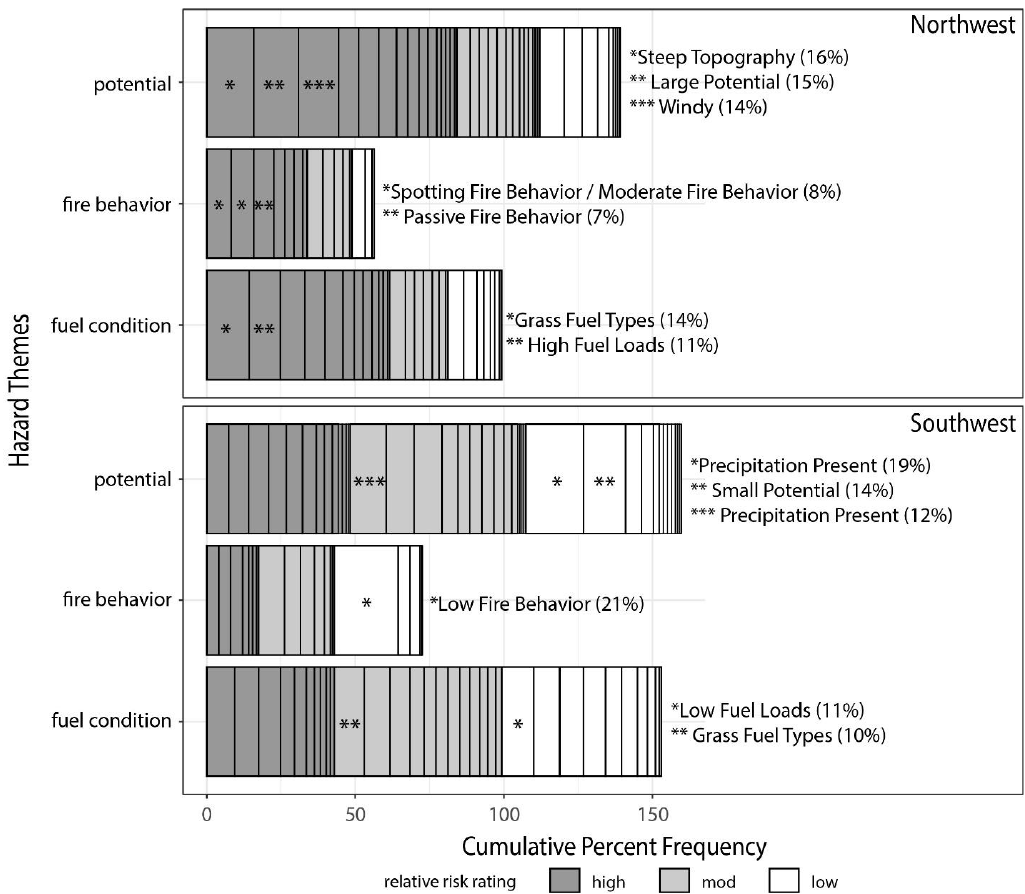
Figure 5. Cumulative percent frequency of codes summarized with ‘Hazard’ themes by high, mod- erate and low relative risk ratings for the Northwest and Southwest Geographic Areas (GAs). The most common codes and their percent frequency are listed in the figure and available in Table 2 and Appendix B.